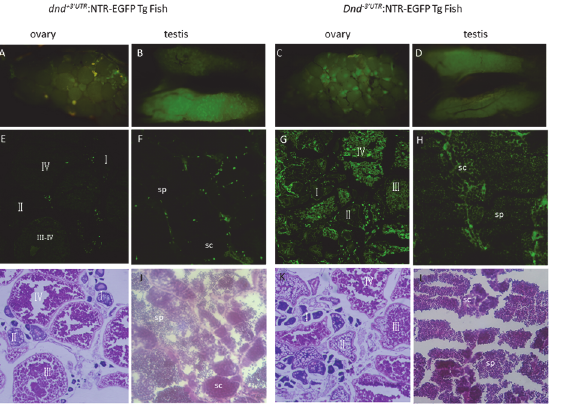
Fig 3. Gonadal expression of the dnd +3 ’ UTR :NTR-EGFP and dnd -3 ’ UTR :NTR-EGFP transgene in adult zebrafish. Anatomical views of the gonadal expression of the NTR-EGFP transgene are presented in A-D; Views of NTR-EGFP trangene expression and histological features with HE staining in the cyosectioned gonadal tissue are presented in E-H and I-L; A and B) Expression of the transgene in zebrafish ovary (A) and testis (B) in dnd +3 ’ UTR :NTR-EGFP transgenic fish at 100 dpf; C and D) Expression of the transgene in zebrafish ovary (C) and testis (D) in dnd -3 ’ UTR :NTR-EGFP transgenic fish at 100 dpf; E and F) NTR-EGFP transgene expression in the cryosections of the ovary (E) and testis (F) of the F1 progenies of dnd +3 ’ UTR : NTR-EGFP transgenic fish at 100 dpf; G and H) NTR-EGFP transgene expression in the cryosections of the ovary (G) and testis (H) of the F1 progenies of dnd -3 ’ UTR :NTR-EGFP transgenic fish at 100 dpf; I-J) histological features with HE staining for the I-J) shows the HE staining for the cryosections of the ovary (I) and testis (J) of the F1 progenies of dnd +3 ’ UTR :NTR-EGFP transgenic fish at 100 dpf; K-L) shows the HE staining for the cryosections of the ovary (K) and testis (L) of the F1 progenies of dnd -3 ’ UTR :NTR-EGFP transgenic fish at 100 dpf; Fluorescence was observed in the oocytes at all stages (E, G, I, K) and in spermatocytes(sc) and sperm(sp) (F, H, J,